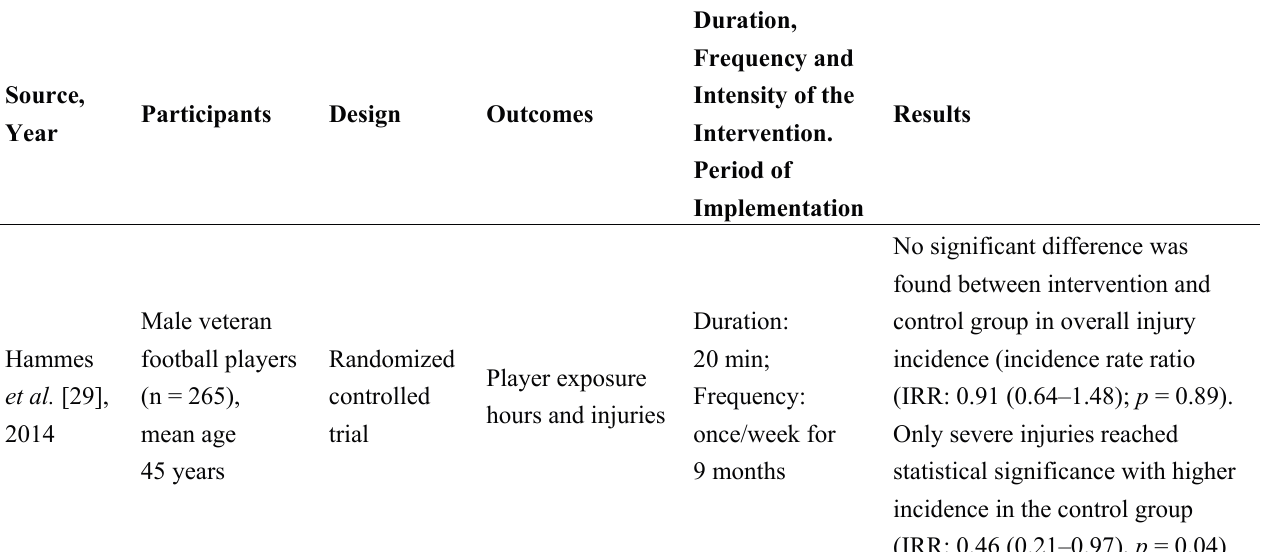
Table 2. Summary of the FIFA 11+ studies assessing the impact of the program on incidence or number of injuries according to year, country, design, outcome measures and